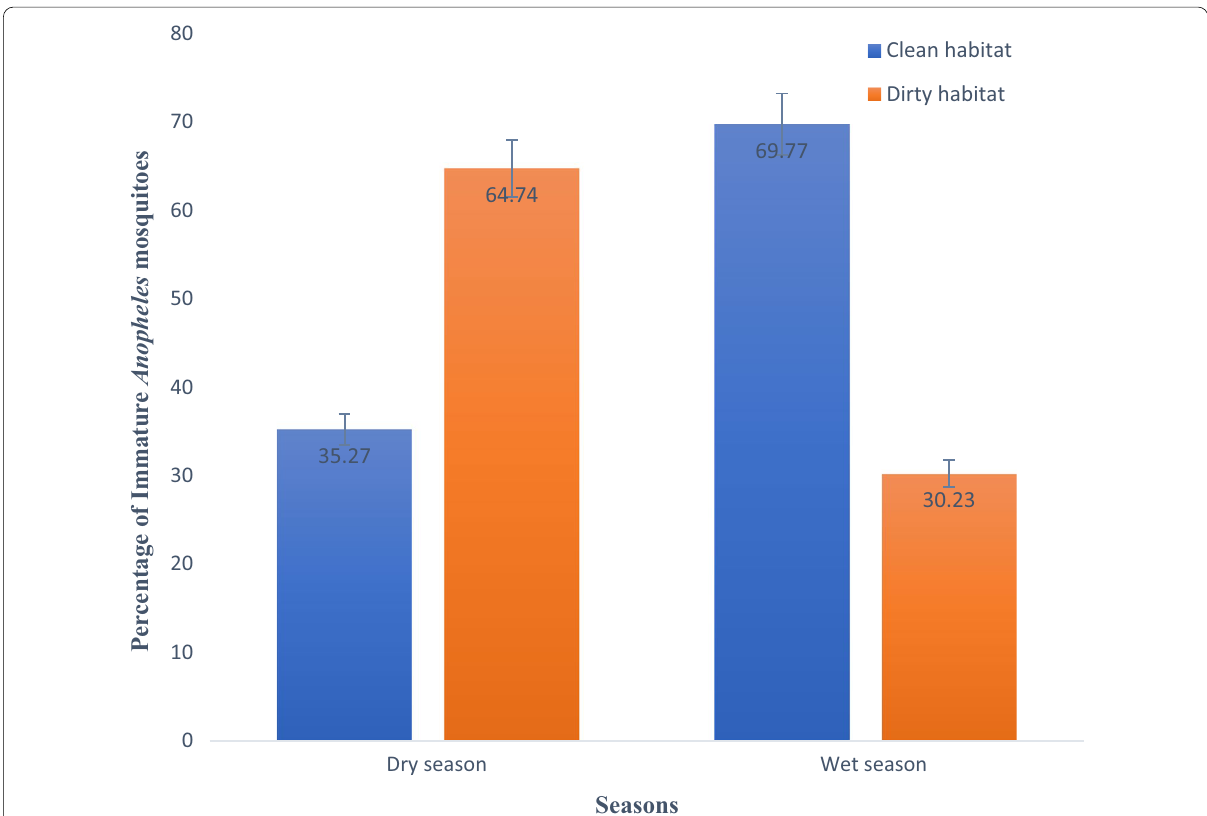
Fig. 3 Seasonal distribution and composition of immature Anopheles mosquitoes in the study areas